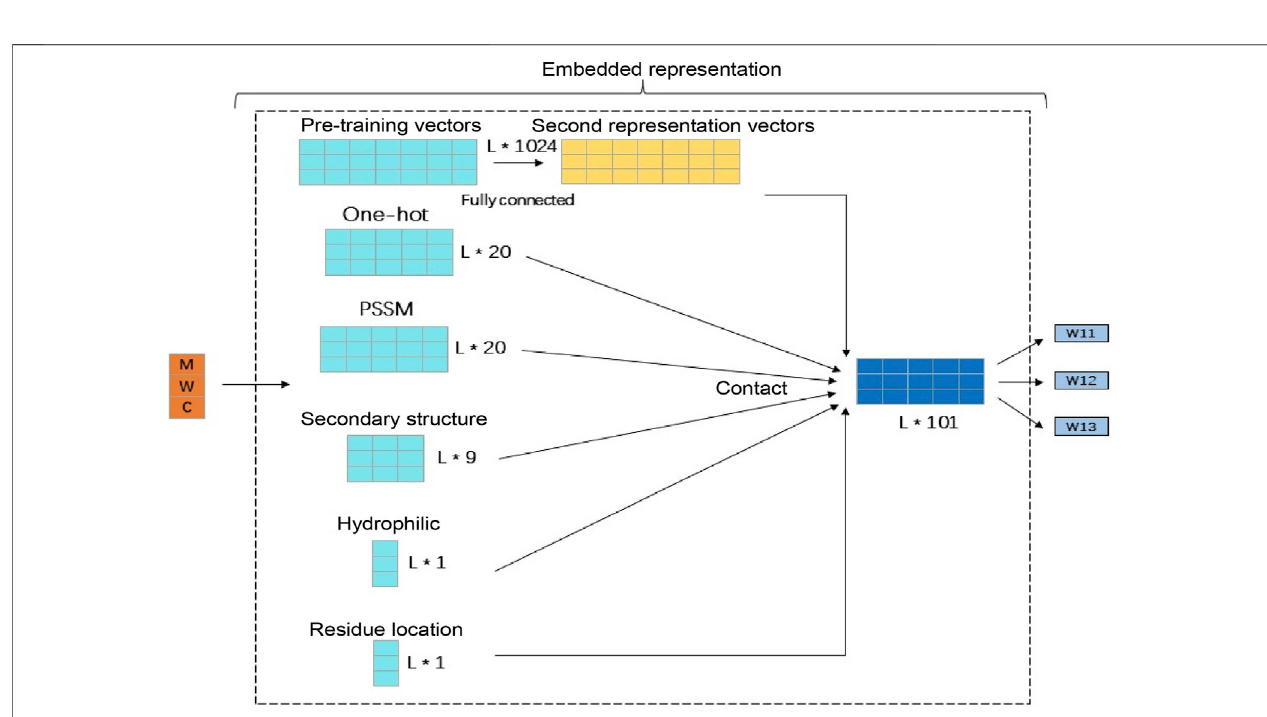
FIGURE 2| Amino acid feature generation and expression. This fi gure illustrates the speci fi c details of the amino acid signature generation. Among them, because the pre-training vector feature dimension is too large, a layer of feedforward neural network is used to reduce the dimension to 50 dimensions. Then, the remaining fi ve features are spliced and fi nally the 101-dimensional amino acid feature vector as the input of the entire model is obtained.